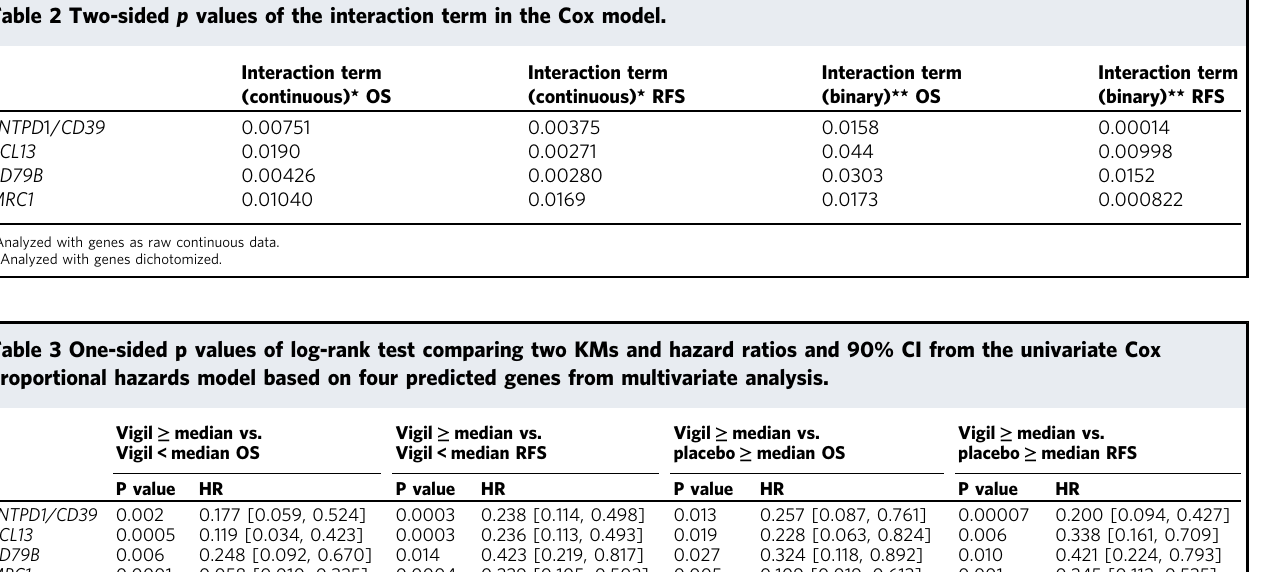
Table 2 Two-sided p values of the interaction term in the Cox model.